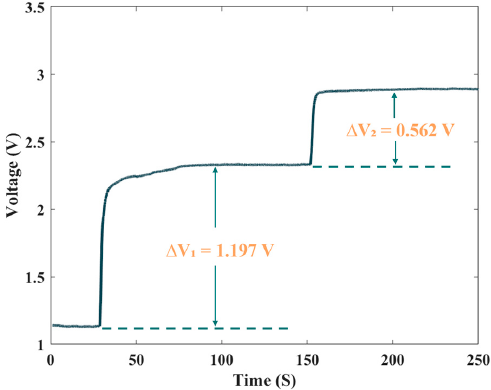
Figure 10. Concentration signal graph.